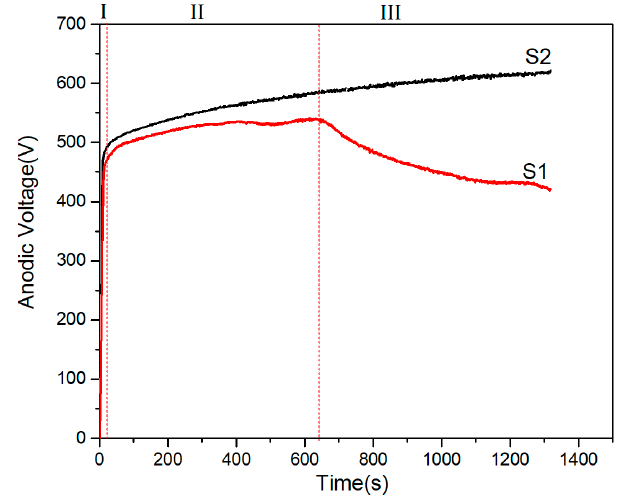
Figure 2. Anodic voltage–time response during PEO of Ti6Al4V alloy with CS-coating using soft sparking mode and unipolar mode.